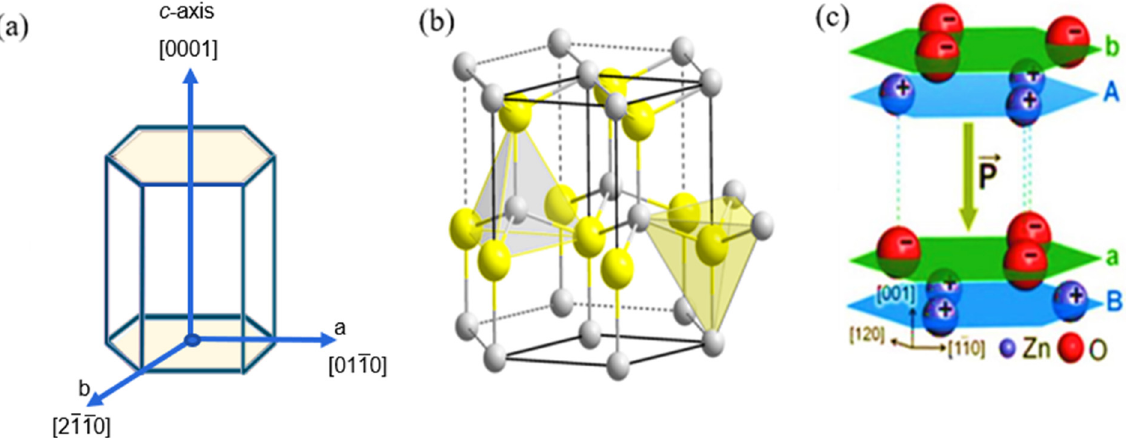
Figure 2. ( a ) Crystal structure of hexagonal wurtzite ZnO along the polar axis with different crys- tallographic facets. ( b ) The hexagonal wurtzite structure of ZnO with the tetrahedron coordination; O (grey spheres) and Zn (yellow spheres). ( c ) Alternate layers of positive and negative ions in ZnO with a non-centrosymmetric structure, which causes spontaneous polarization. Reprinted from Refs. [34–36].